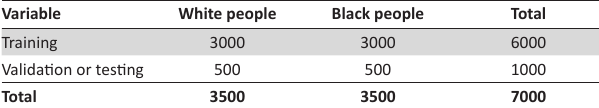
TABLE 2: Number of training and validation images for dataset